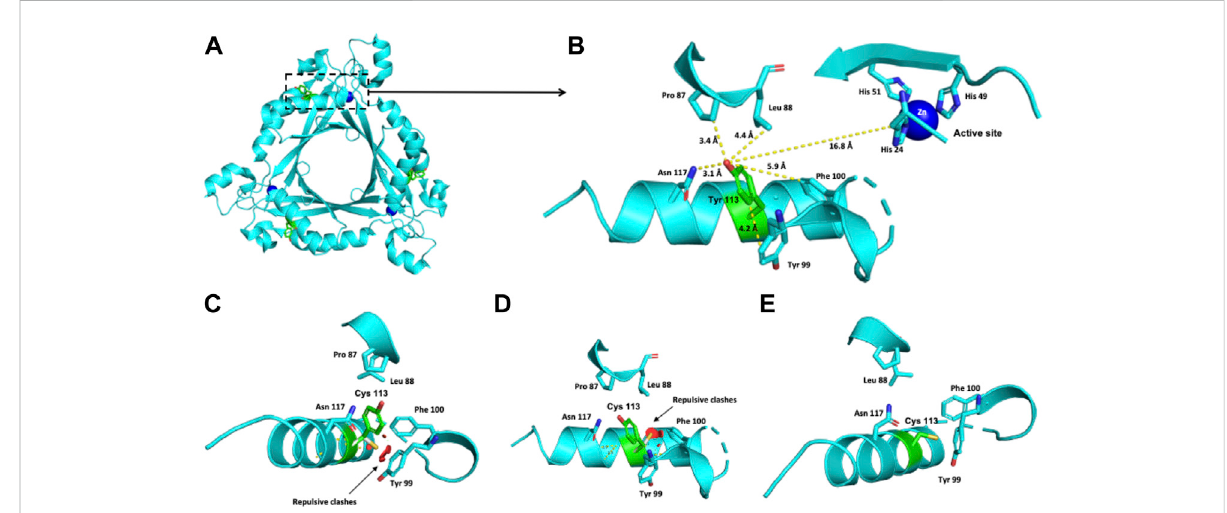
FIGURE 1 Modeling of the human PTPS structure with p.(Tyr113Cys) change. (A) Crystallographic structure of a trimer of PTPS and the location of the Tyr 113 residue on each monomer. (B) Location of the Tyr 113 residue in one monomer. (C – E) Potential pathogenic effects for the substitution of Tyr by Cys.